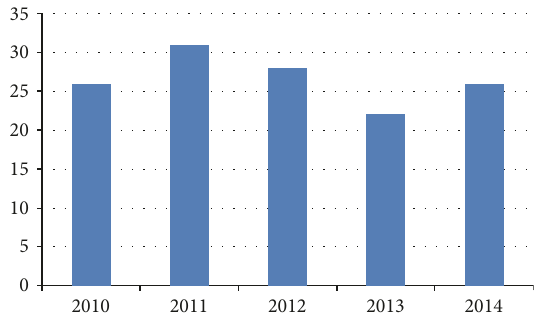
Figure 1: Number of complications during phacoemulsi fi cation per year (2010 – 2014).